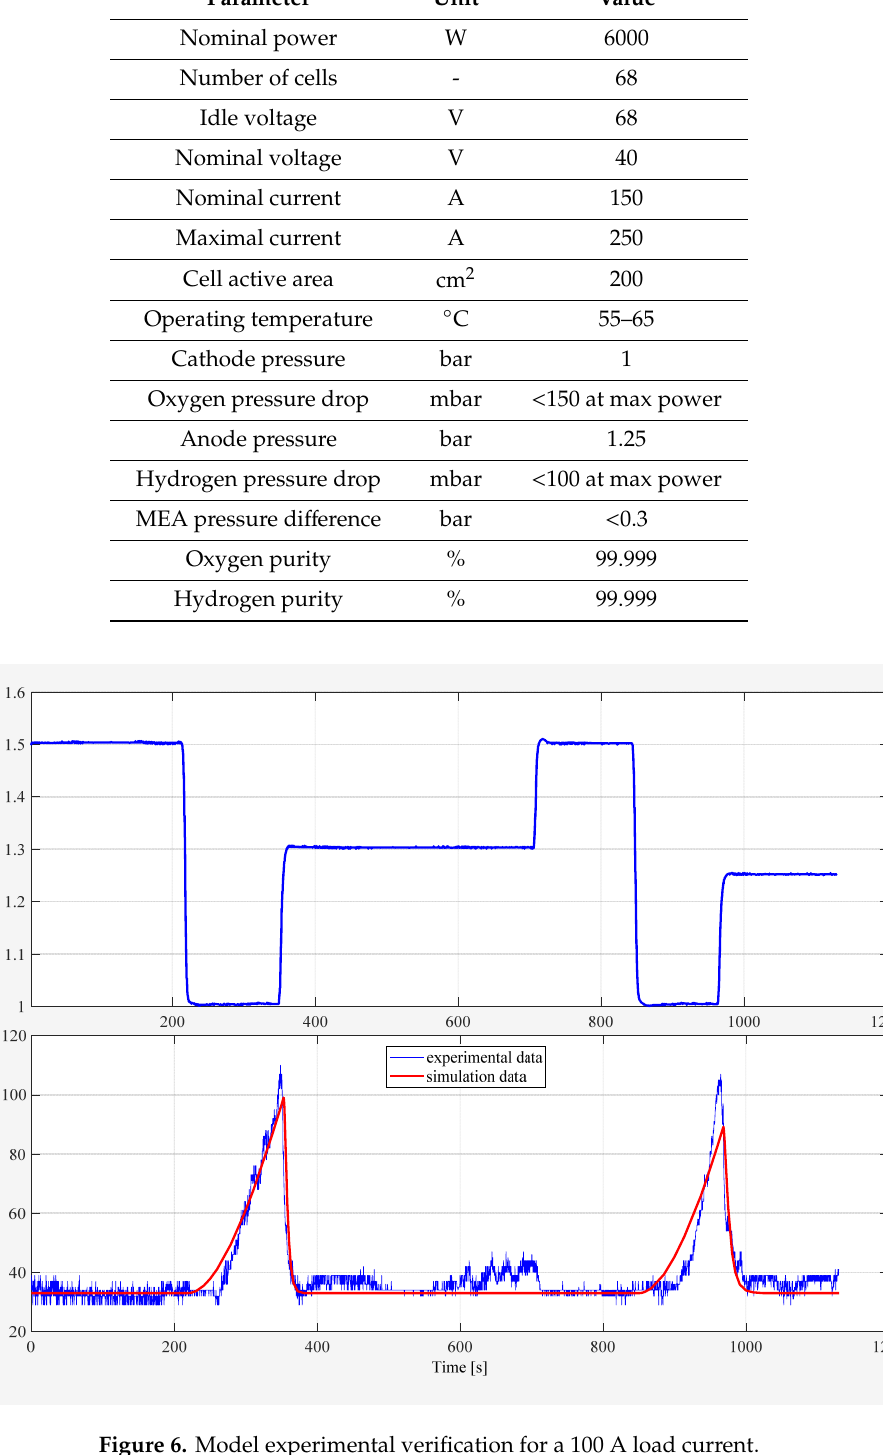
Figure 6. Model experimental verification for a 100 A load current.